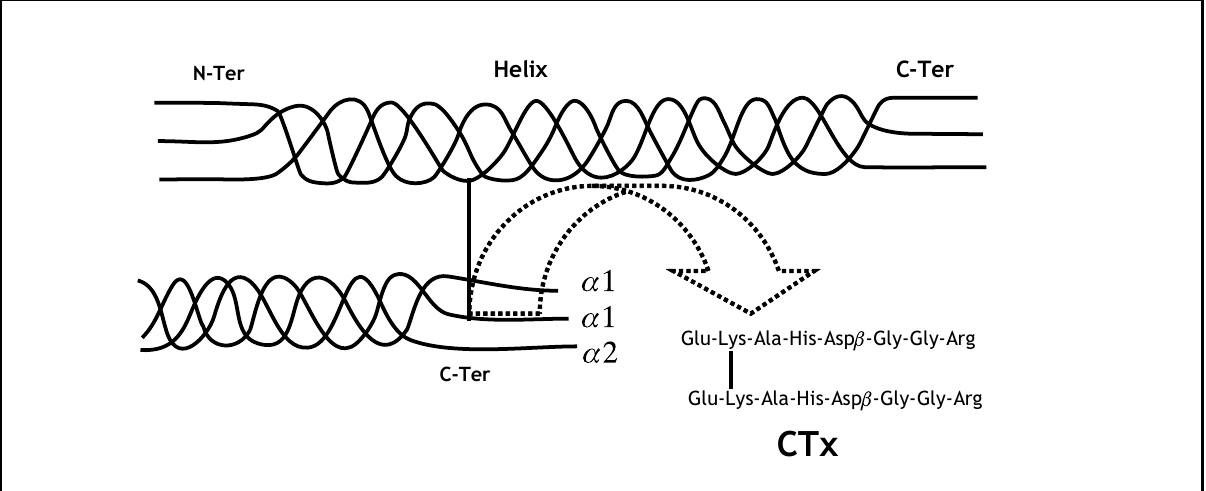
Figura 1 – Representação esquemática da origem dos fragmentos carboxiterminais do colágeno tipo I. A digestão do colágeno maduro libera peptídeos únicos originados pela associação entre as diferentes